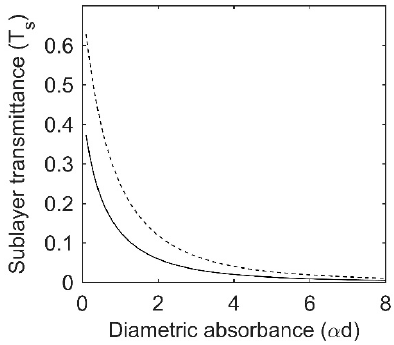
Figure 2. Sublayer transmittance T s ( n , α d , x u , x d ) as a function of diametrical absorbance α d . n is the refractive index, x u and x d are the particle backscattering and forward scattering ratios, respectively. They were set to fixed values 1.45, 0.2, 0.6 respectively. Dashed line denotes the theoretical value calculated by Equation (11), solid line is derived using Equation